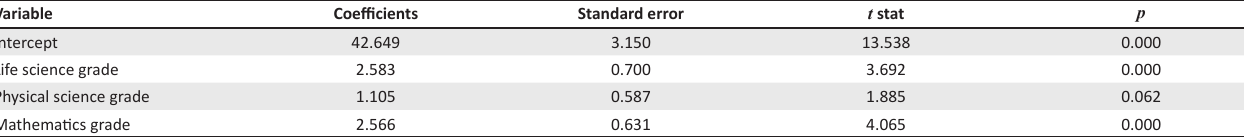
TABLE 4: Multiple regression model summary predicting grade for first year science modules. Variable